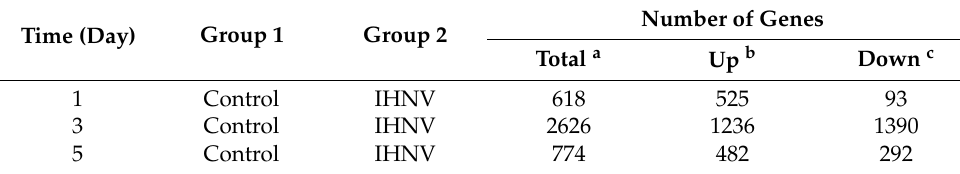
Table 1. Comparative analysis of DEGs between groups 1 and